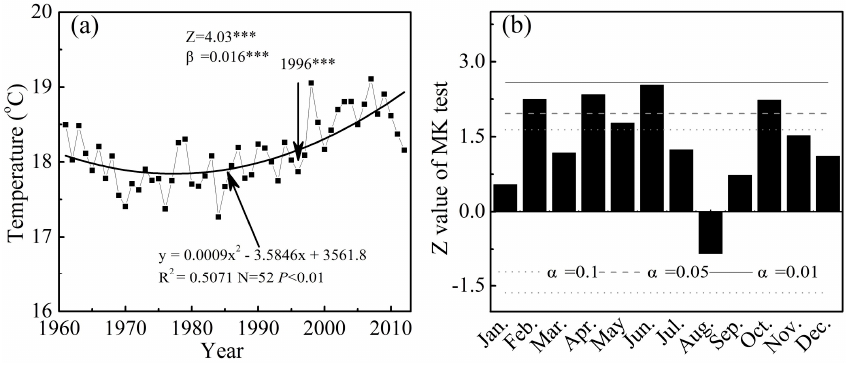
Figure 11. Temperature change ( a ); and the trend of monthly temperature ( b ) in the Poyang Lake Basin from 1961 to 2012 (*** significant at P ≤ 0.01).